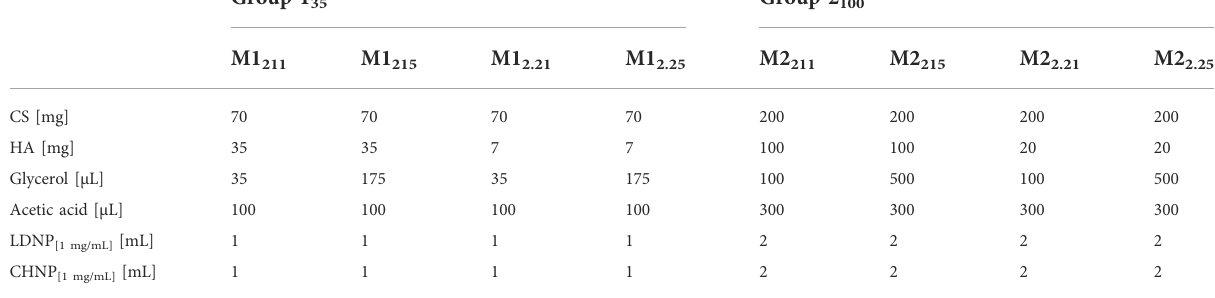
TABLE 1 Biomembranes: Designed